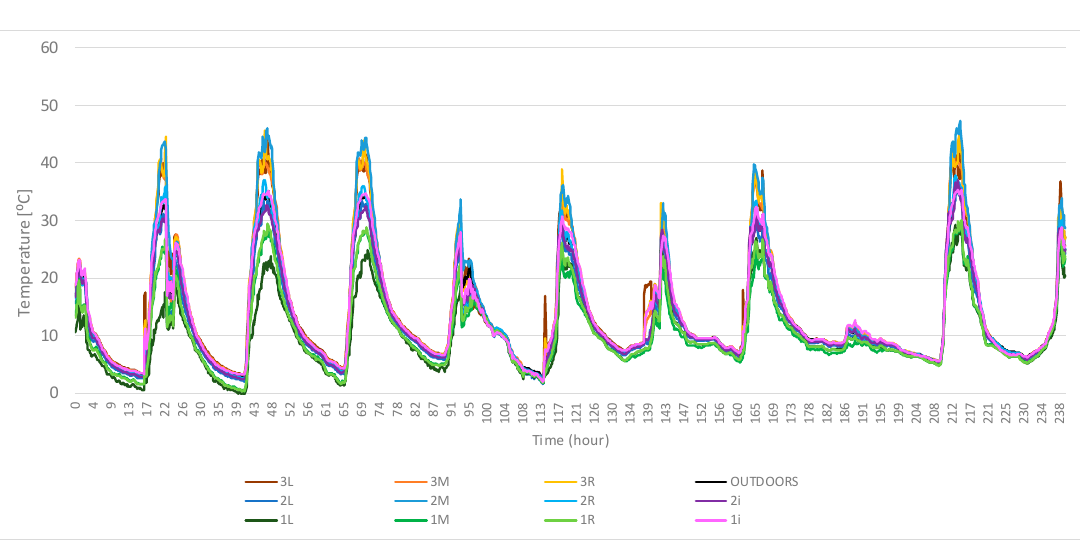
Figure 4. Outdoor, indoor and façade temperatures registered from 5 November to 5 December.